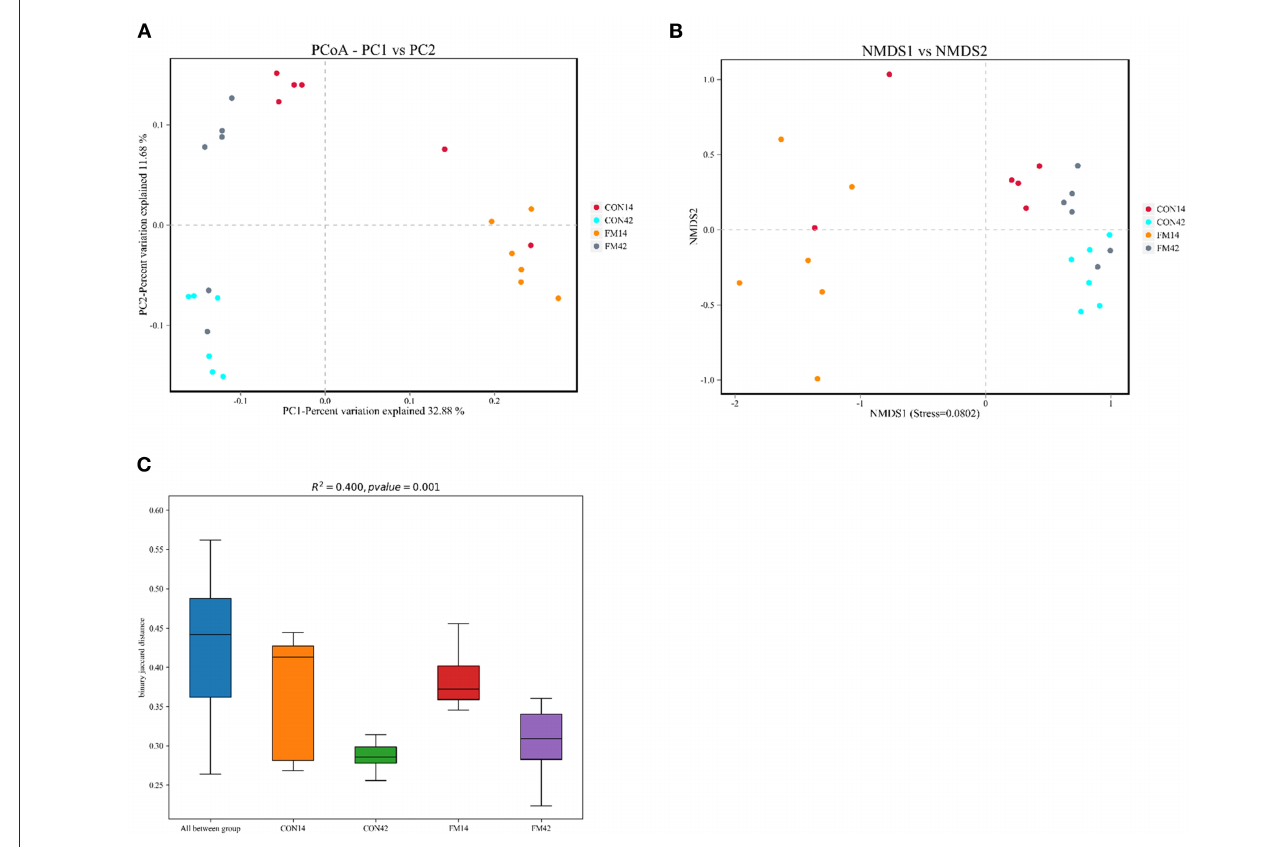
FIGURE9 Comparison of fecal microbiota structure by β -diversity [ (A) : PCoA; (B) : NMDS; (C) : box